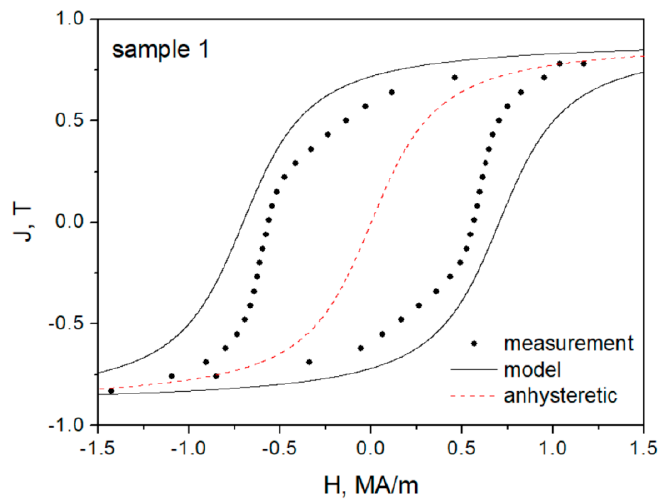
Figure 9. An attempt to model the hysteresis loop of Sample 1 using two term polynomials for the description of the irreversible field component.